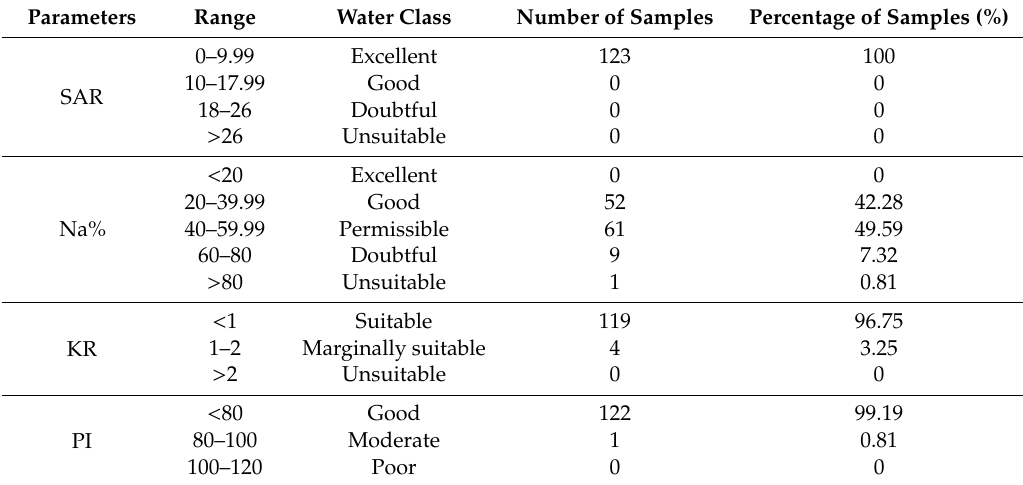
Table 6. Classification of groundwater samples collected from the Jinta Basin, China according to calculated parameters